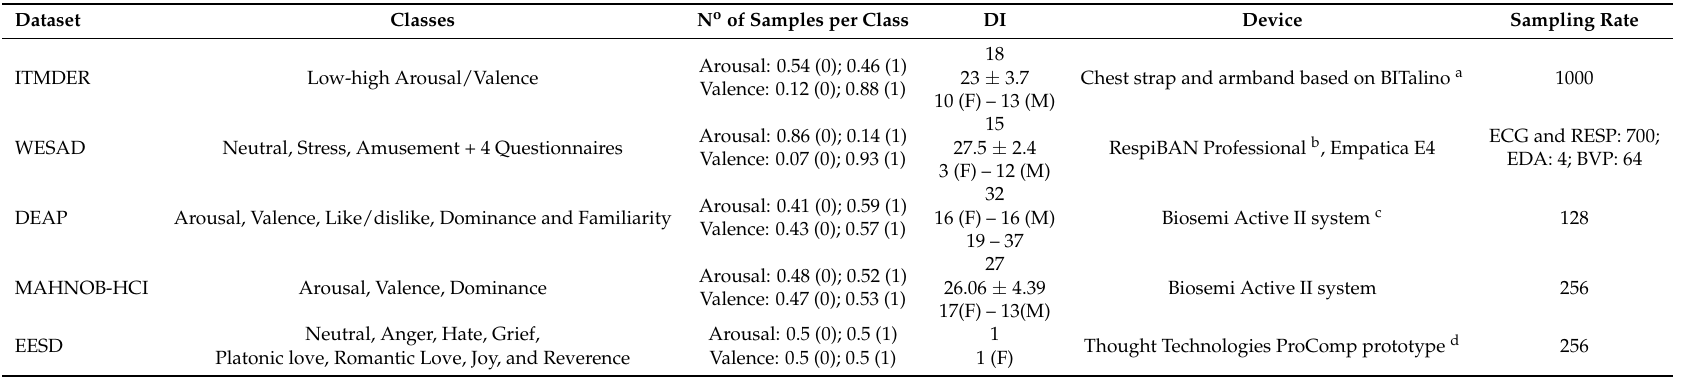
Table 1. Summary of the datasets information on: classes; ratio of number (N o ) of samples per class label shown between parenthesis—N o samples per class label/ total number of samples, for the classes 0 and 1, shown between parenthesis; demographic Information (DI)—number of participants; ages (years old) ± standard deviation, and Female (F)-Male (M) subject distribution; device used for this paper; and sampling rate. Dataset nomenclature: ITMDER—IT Multimodal Dataset for Emotion Recognition; WESAD—Multimodal Dataset for Wearable Stress and Affect Detection; DEAP—A dataset for Emotion Analysis using Physiological